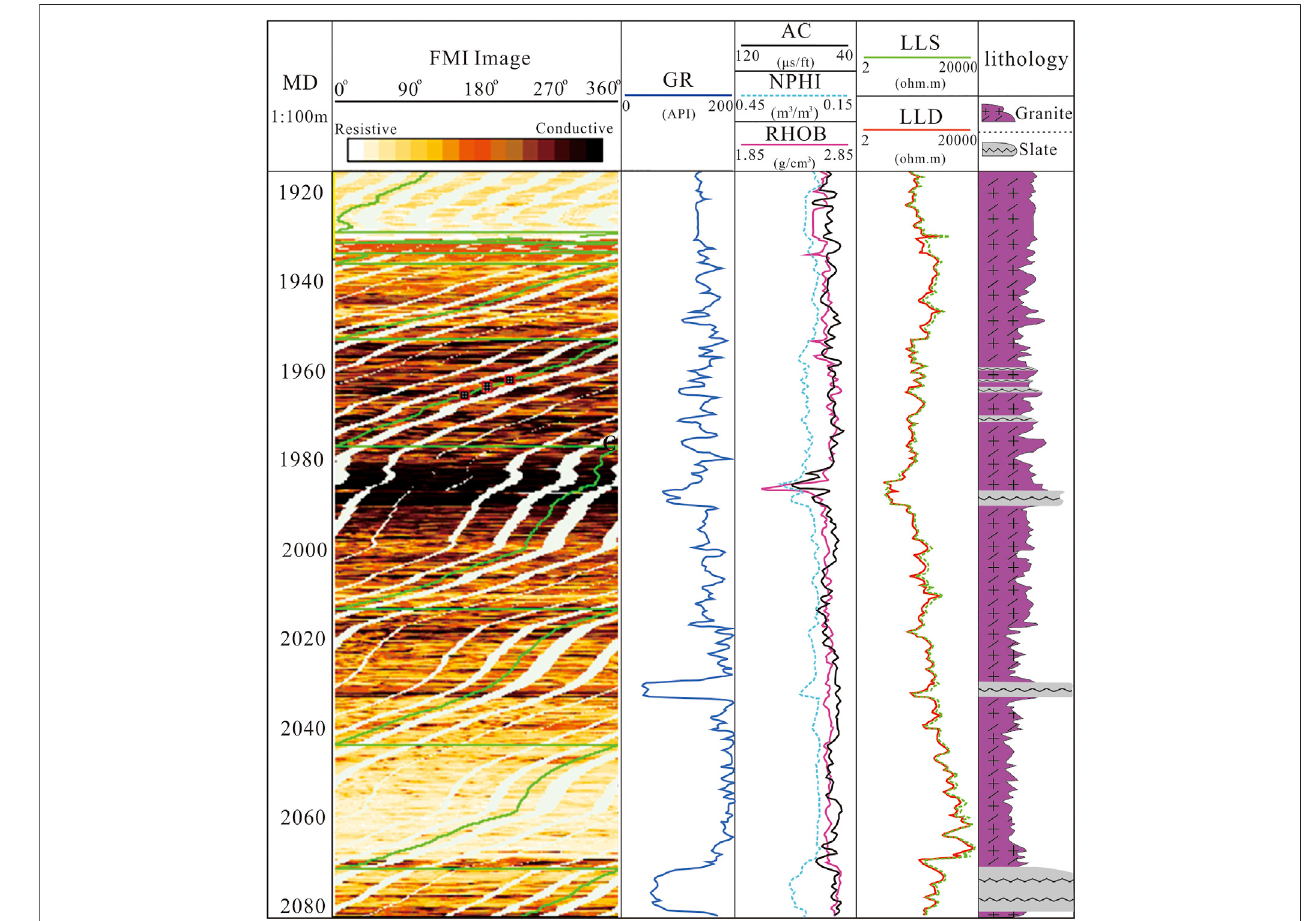
FIGURE 2 | FMI image and logging response of bedrock sections from the well W5. See Figure 1 for well W5 location.